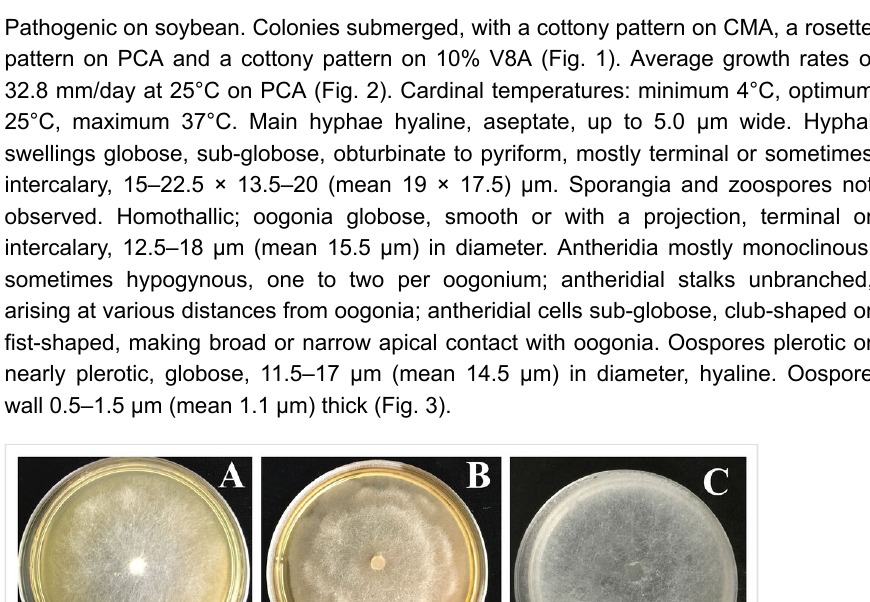
Figure 1. Colony patterns of Pythium huanghuaiense (Chen 94) on A. CMA; B. PCA; and C.